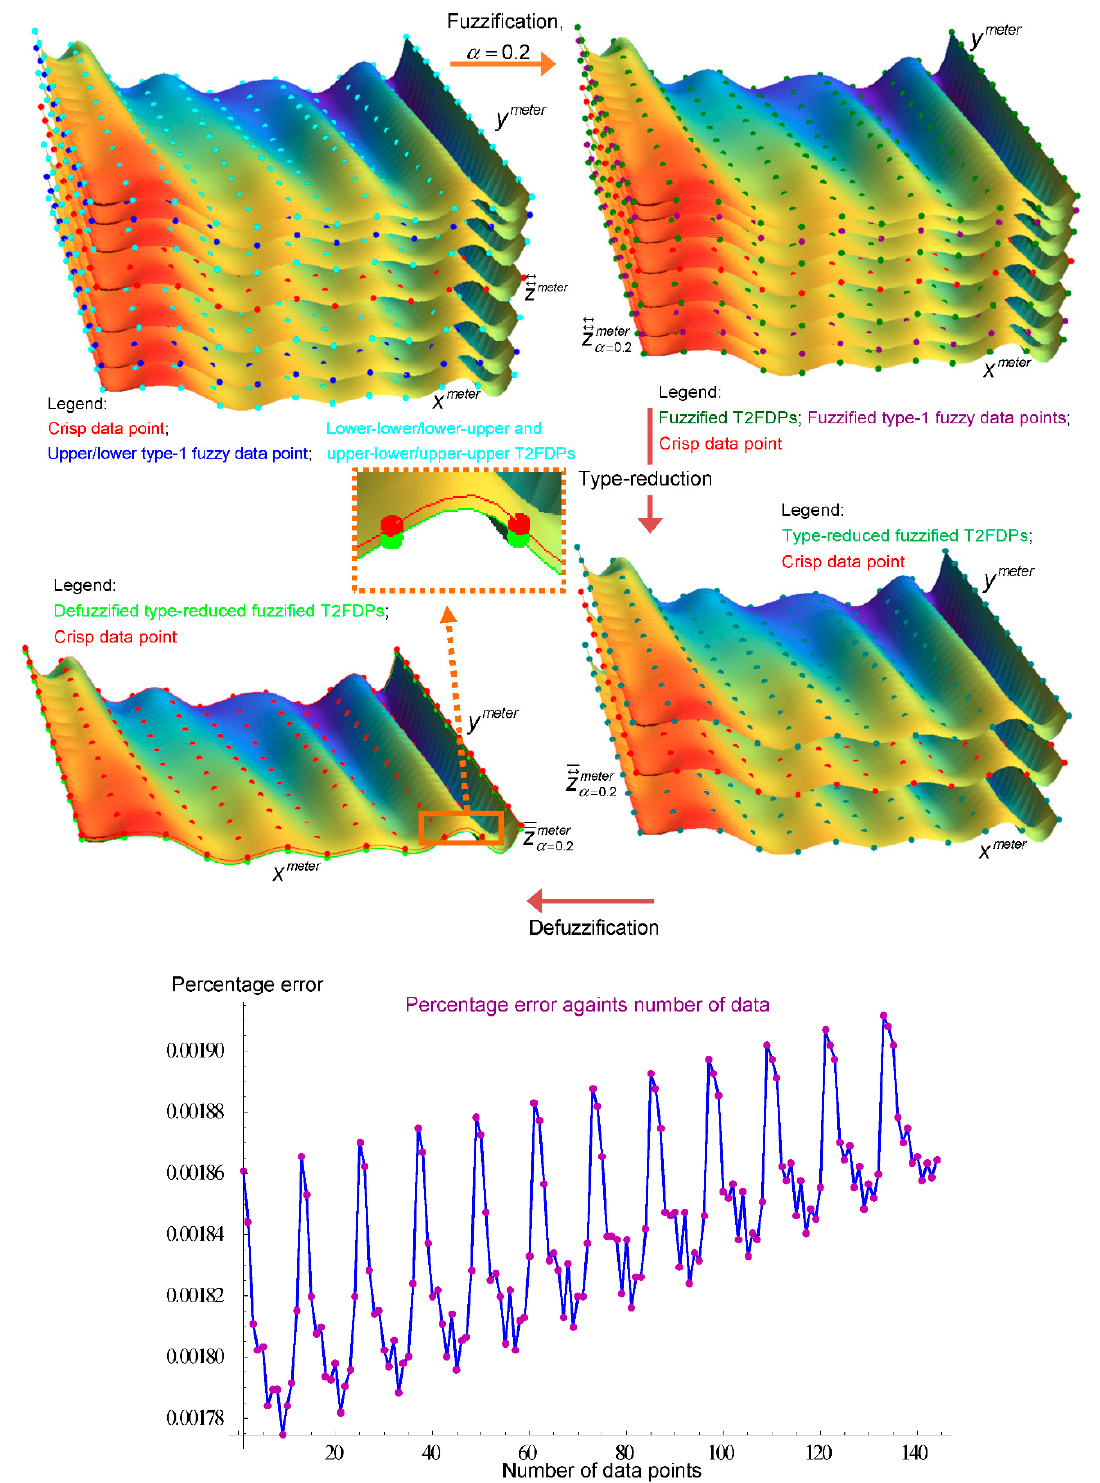
Figure 12. The T2FIBsS modeling through fuzzification until defuzzification processes along with the error plot.